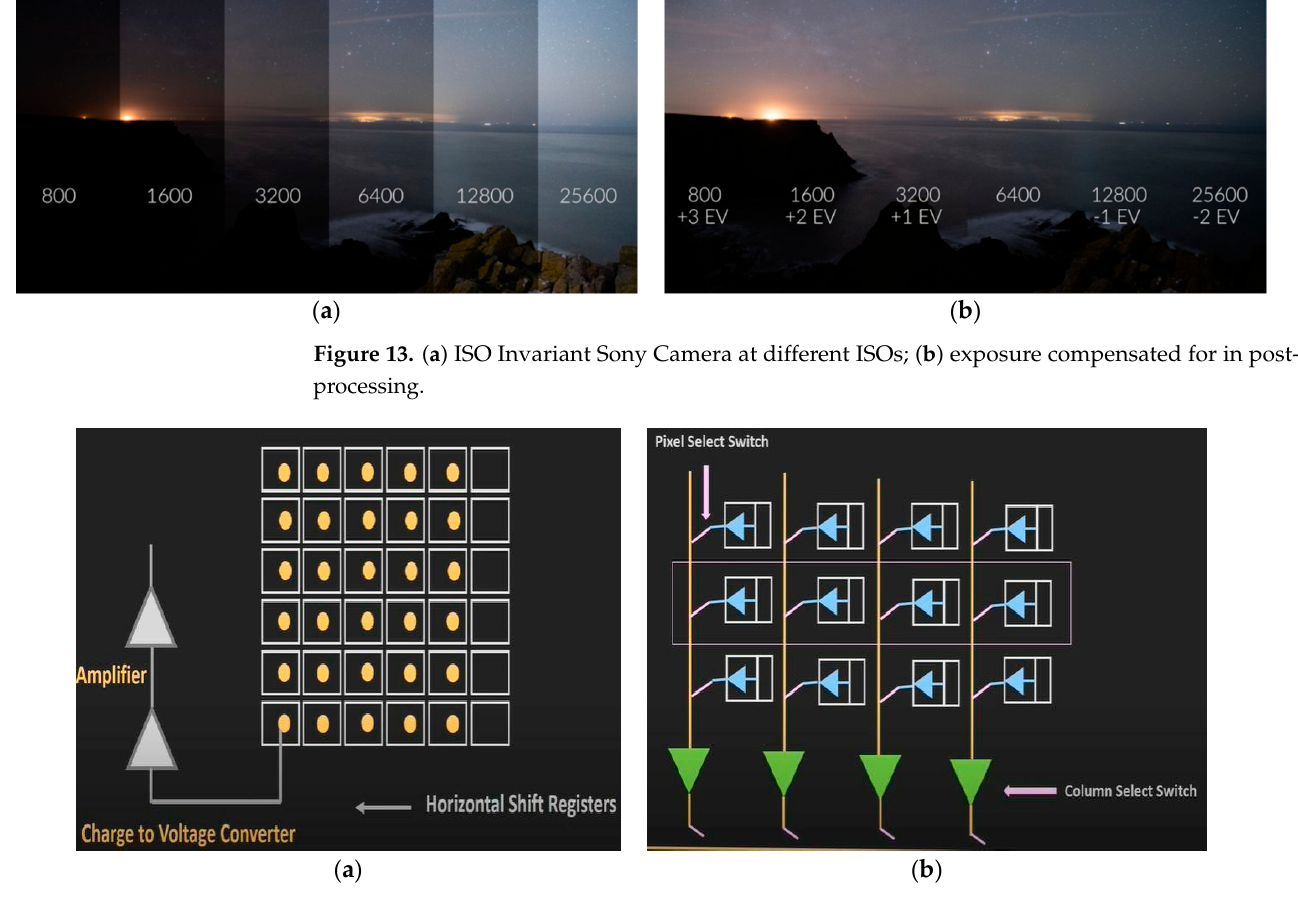
Figure 14. ( a ) CCD sensor schematic diagram; ( b ) CMOS sensor schematic